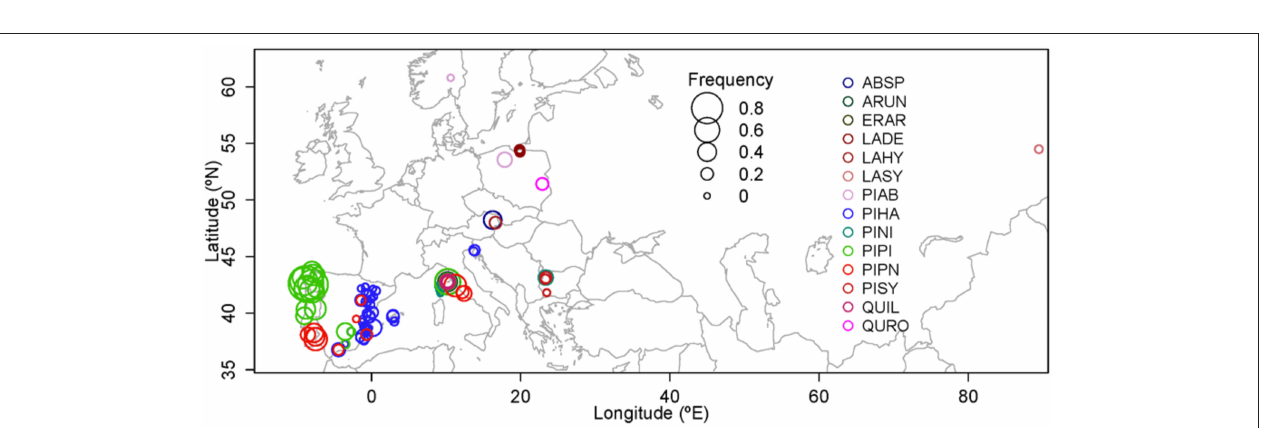
FIGURE 1 | Heatmap showing IADFs for two different provenances of Abies alba : a fast-growing (P19, n = 17 ) and a slow-growing provenance (P45, n = 24 ). The slow-growing provenance showed less IADFs (26%) than the fast-growing provenance (70%). Solid lines indicate the tree-ring width and dashed lines the mean tree-ring width; the mean tree-ring width in the fast-growing provenance (3.3mm) was twice as wide than in the slow-growing provenance (1.5mm).